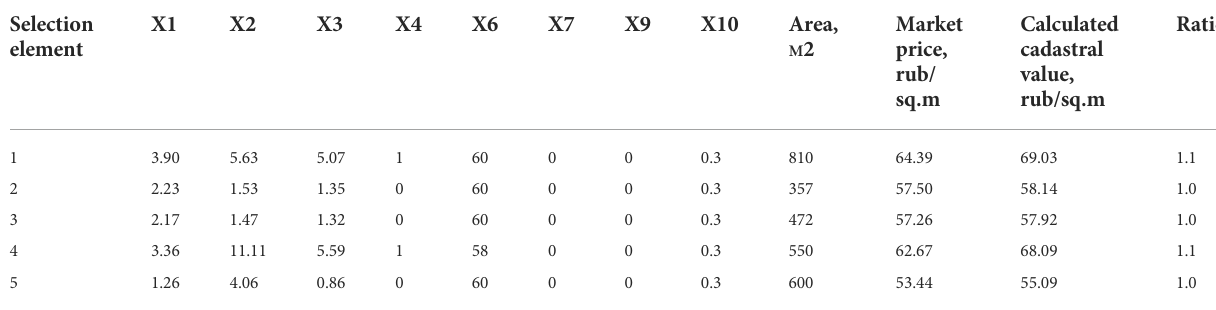
TABLE 5 Checking the predictive ability of the model on the control sample. Selection element